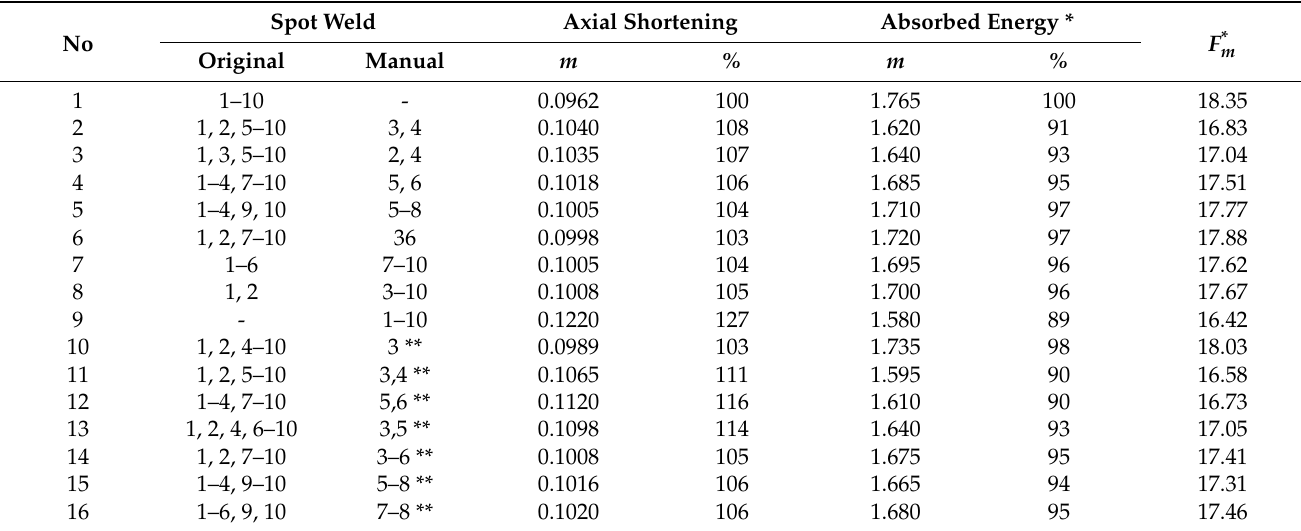
Table A3. Variants of the original and manual spot-welded joint layout in the FE